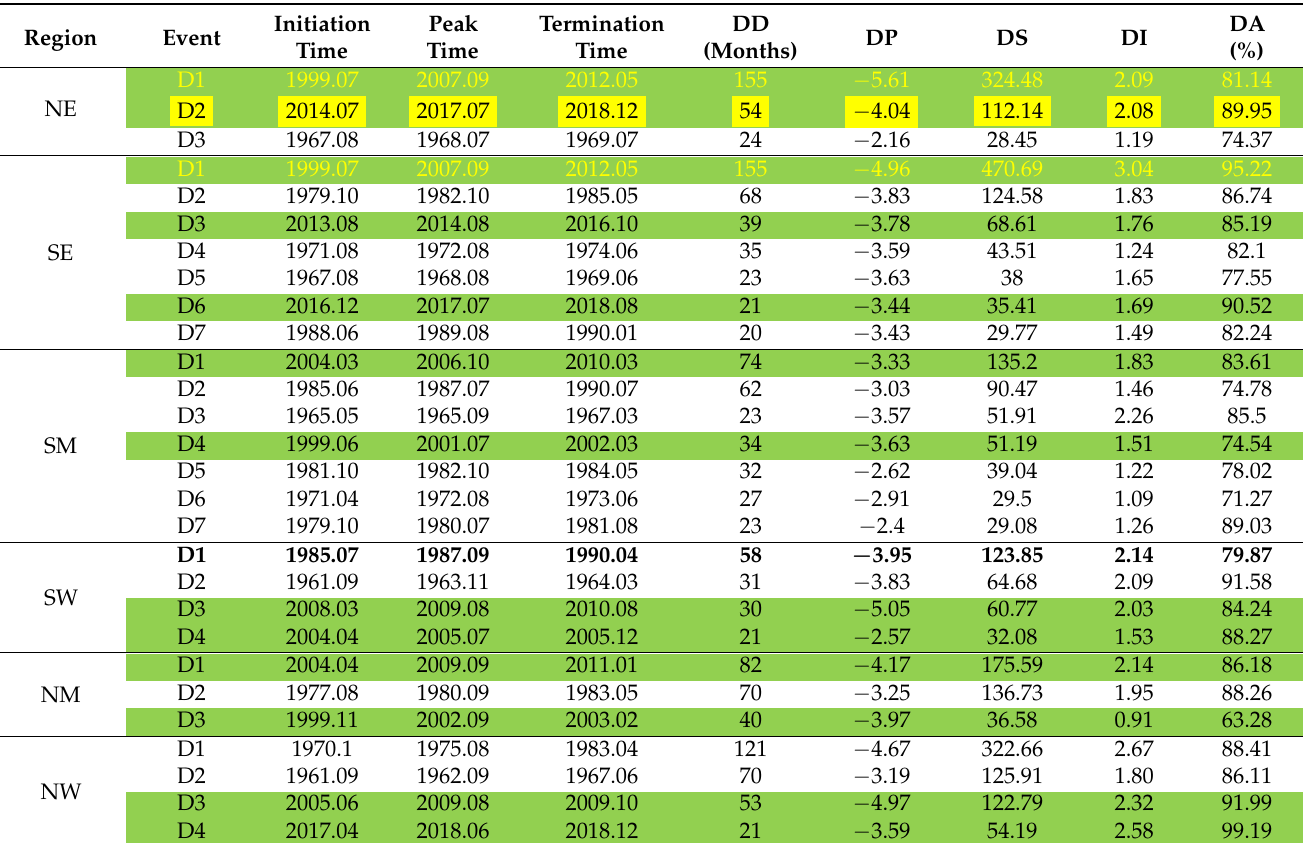
Table 3. Drought characteristics of typical drought events with durations >20 months occurring in the six sub-regions from 1959 to 2018. The green color represents drought events occurring in the time period of 1996–2018 in the six sub-regions. Dx represents the drought event, and the x shows the most severe drought events in six sub-regions. The smaller the number, the more serious the drought